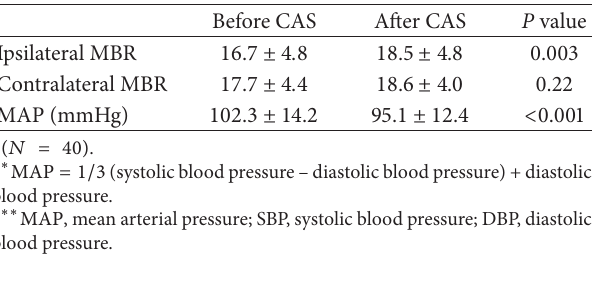
Table 2: Patient characteristics.